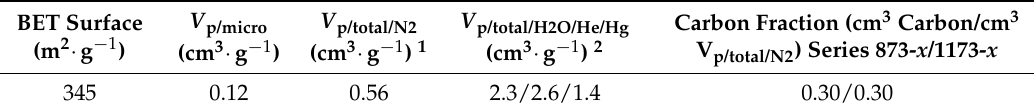
Table 1. Textural data of the porous concrete template and the carbon fraction of the template-carbon-composites. BET Surface